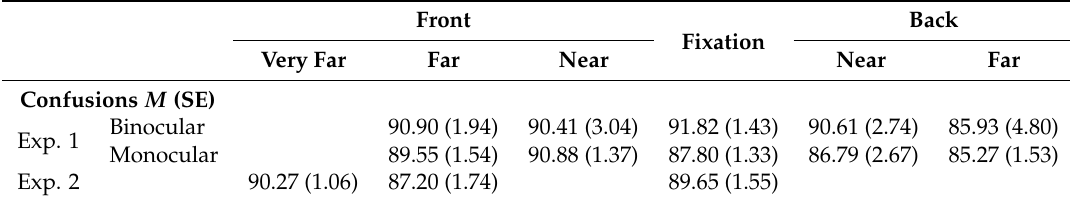
Table 1. Percentage of flanker confusions in all incorrect responses as a function of flanker distance and flanker direction in